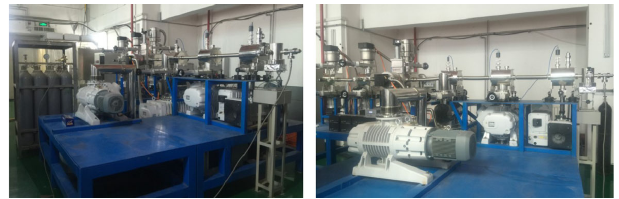
FIG. 17. The layout of the VDS prototype.